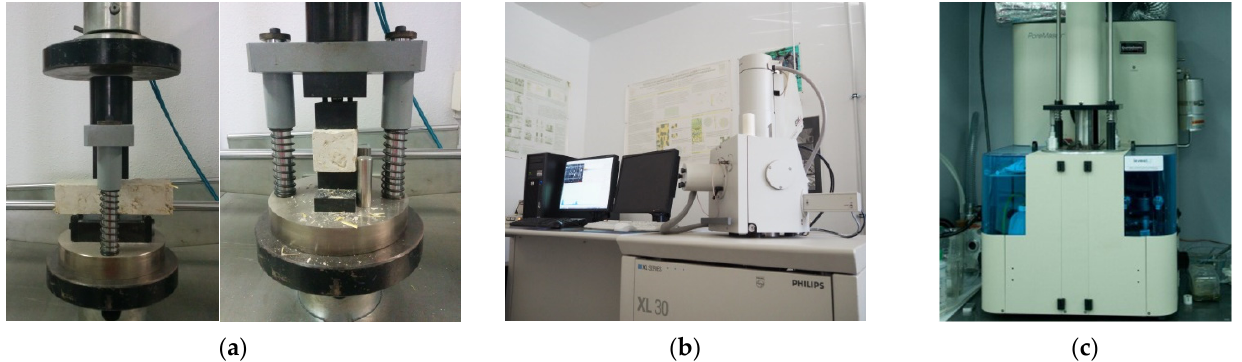
Figure 3. Equipment used for the several test methods conducted for the gypsum plasters and cement mortars characterization: ( a ) Suzpecar multi-test press for flexural and compressive strength tests; ( b ) Phillips XL-30 Scanning Electron Microscope used for SEM tests; ( c ) Poremaster 60 GT used for MIP tests.